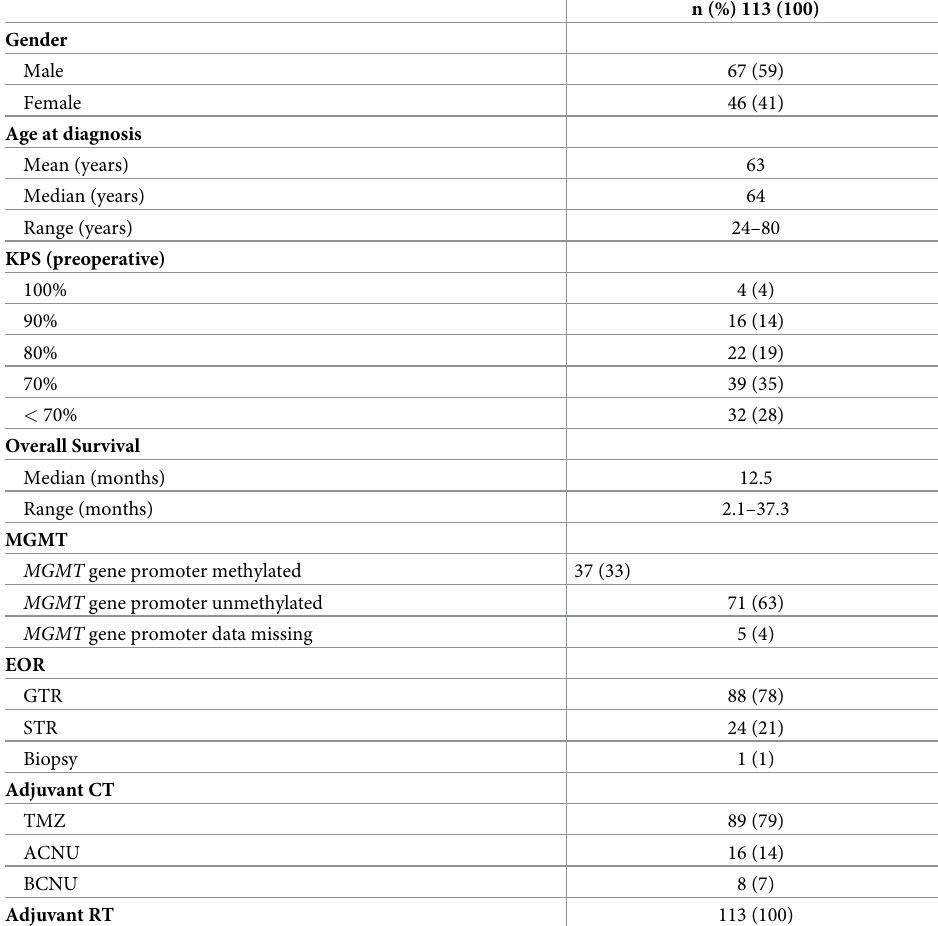
excluded if the amount of tumor tissue was insufficient for processing into tissue microarrays (TMA). This left 117 eligible patients with GBM that underwent sequencing for IDH1 and IDH2 mutations. Subsequently, 4 cases with IDH 1-R132H mutations were excluded and 113 patients, who were diagnosed with IDH-wildtype glioblastoma WHO grade IV, were left for final analyses. A summary of clinical information of the patient cohort can be found in Table 1. Specimen selection and tissue microarray (TMA) preparation Paraffin-embedded tumor samples from tumor resections and diagnostic biopsies were acquired from the tumor tissue bank of the Institute of Neuropathology of the University Med- ical Center Go¨ttingen. The corresponding hematoxylin and eosin (HE) stained sections from the donor blocks were microscopically re-evaluated by two independent certified Table 1. Patient cohort